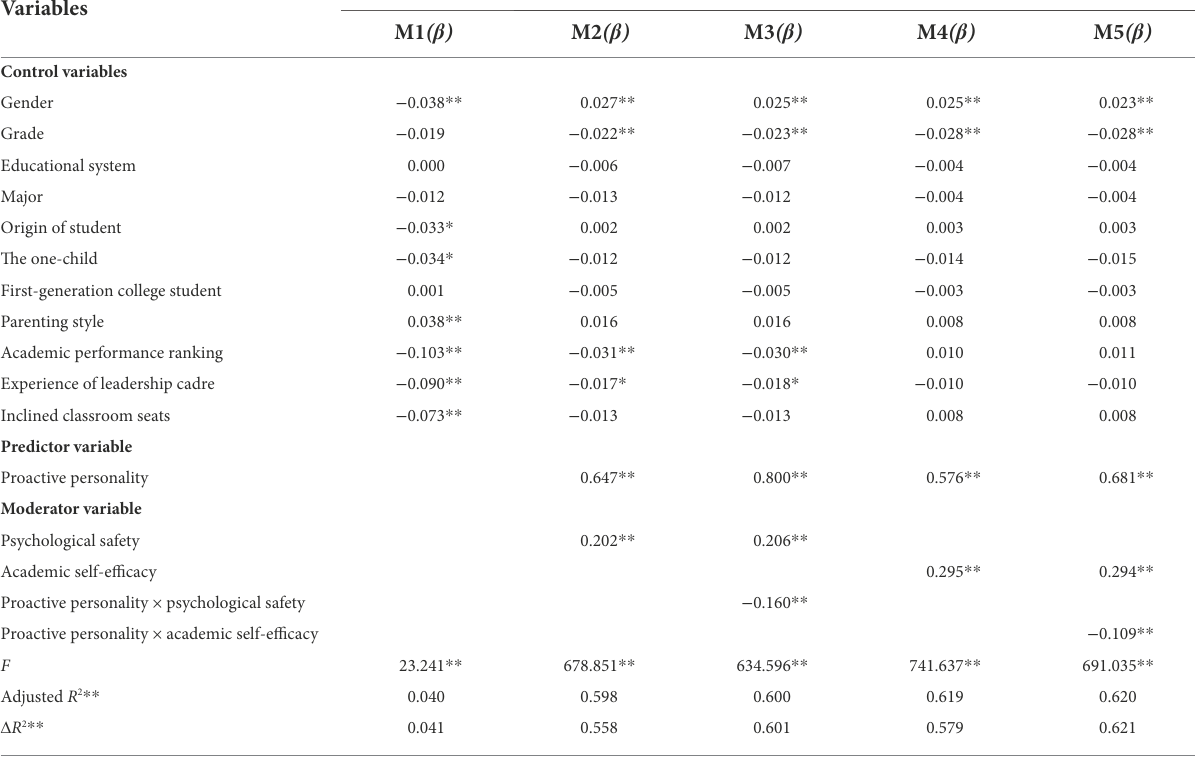
TABLE 3 Hierarchical multiple regression results of critical thinking among medical students ( N = 5,920).